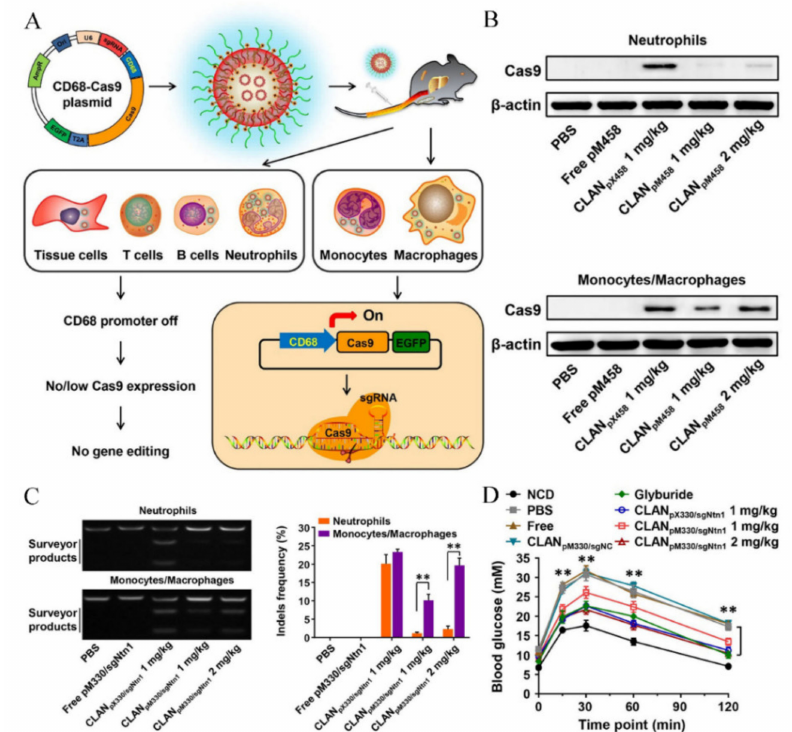
Figure 5. Macrophage-specific in vivo genome editing using CLAN. ( A ) Rational design of CLAN for introducing Cas9 expression plasmids into different cell types. Under the control of CD68 promoter, Cas9 was specifically expressed in macrophages and monocytes. BHEM-chol is a cationic lipid named N , N -bis(2-hydroxyethyl)- N -methyl- N -(2-cholesteryloxycarbonyl aminoethyl) ammonium bromide. ( B ) Cas9 protein expression in neutrophils and monocytes/macrophages 48 h after intra- venous injection. These cells were isolated from peripheral blood, liver, spleen, and adipose tissue. ( C ) Detection of Ntn1 gene disruption efficacy with T7E1 assays after intravenous injection. Surveyor products cleaved by T7EI (left) and indels frequency (right) in the Ntn1 locus. Data are shown as the means ± SD ( n = 5), ** p < 0.01. ( D ) Glucose tolerance tests. Reproduced with permission from